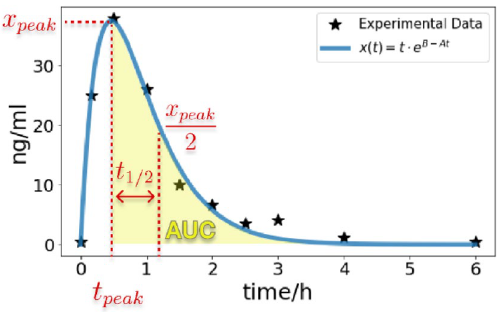
Figure 10. Pharmacokinetic parameters are calculated from the exponential decay curves, fitted to the experimental data. Shown are exemplary data from codeine-6-glucuronide control replicate 4 with fitted parameters A = 2.168 and B = 5.397. Extracted pharmacokinetic parameters are the peak concentration x peak , time of the peak concentration t peak , half-life t 1 / 2 , and area under the curve from the maximum